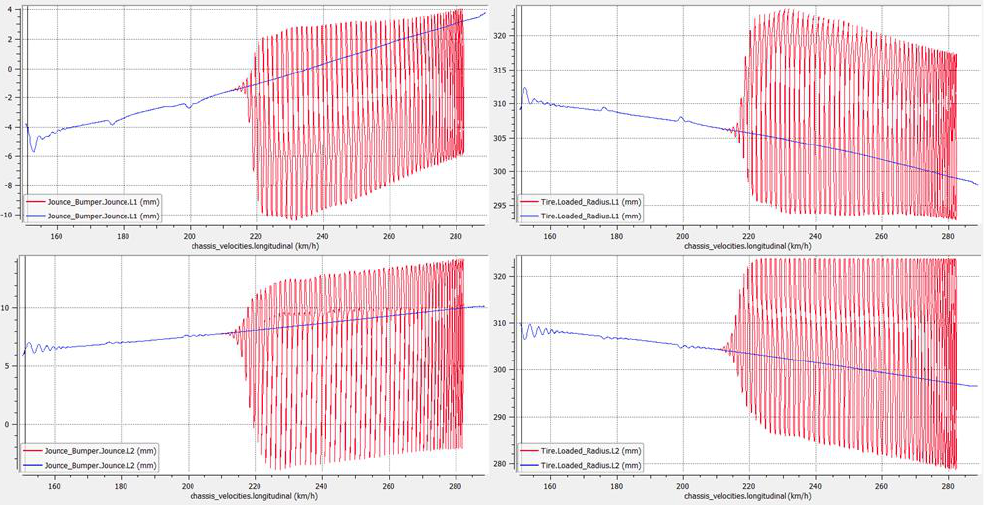
Figure 18. Comparing amplitudes of front and rear suspension jounce ( left ) and tire radial deflection ( right ). The latter is around an order of magnitude larger than the first one: the porpoising phenom- enon appears to be dominated by underdamped bouncing on the tires.